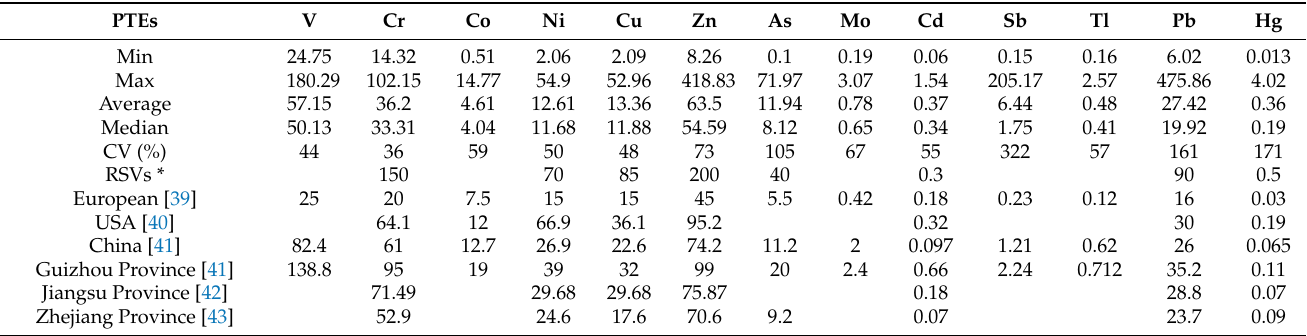
Table 3. PTE contents in the topsoil of the study area and the values from other studies (mg/kg, n =